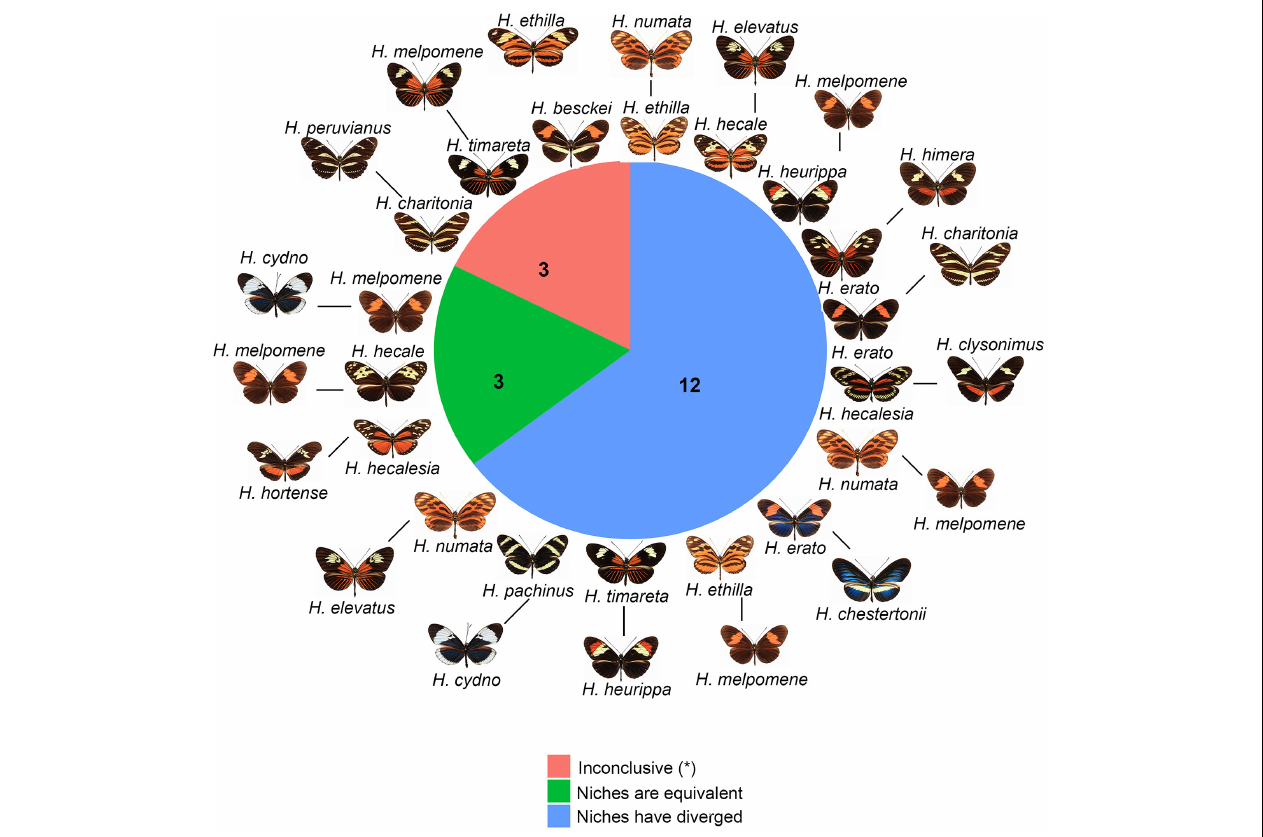
FIGURE 4 | Co-occurring and hybridizing species of Heliconius . Green: species pairs with equivalent environmental niches, blue: species pairs with divergent environmental niches, and salmon: species pairs with inconclusive results. Numbers indicate the pairs of species falling into each